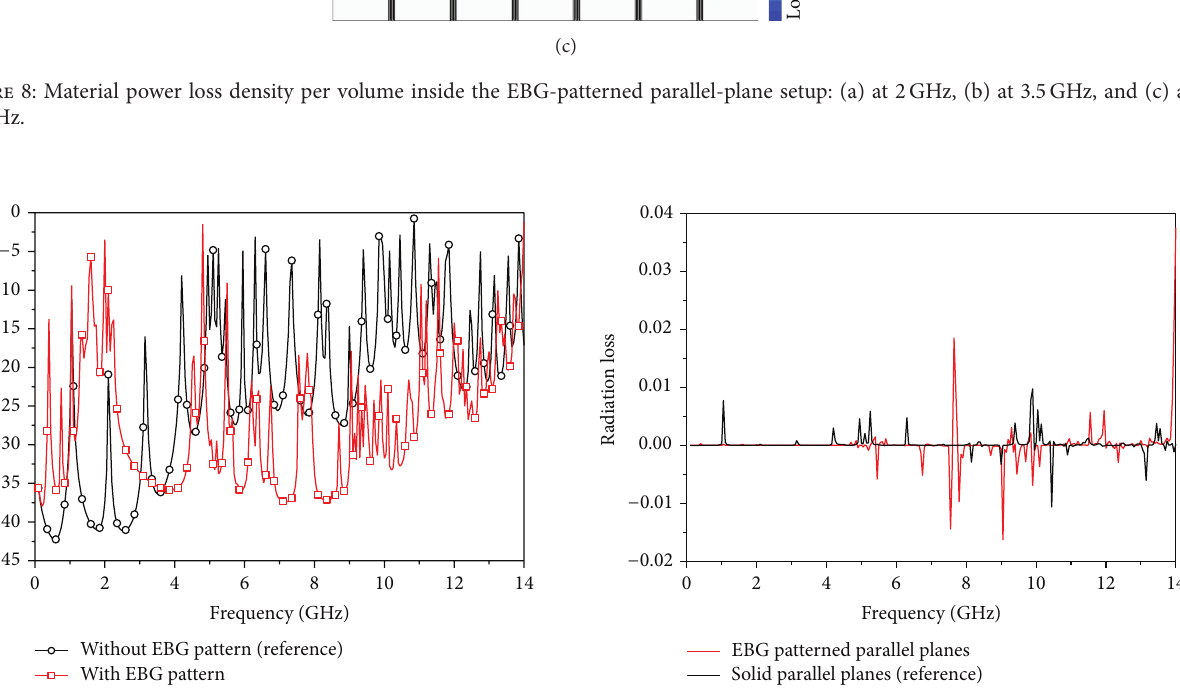
Figure 10: Radiation power loss (1 −|𝑆 11 | 2 − |𝑆 21 | 2 − 𝑃 frequency for two setups defined in the caption of Figure 6. The is presented in Figure material loss 𝑃 LM